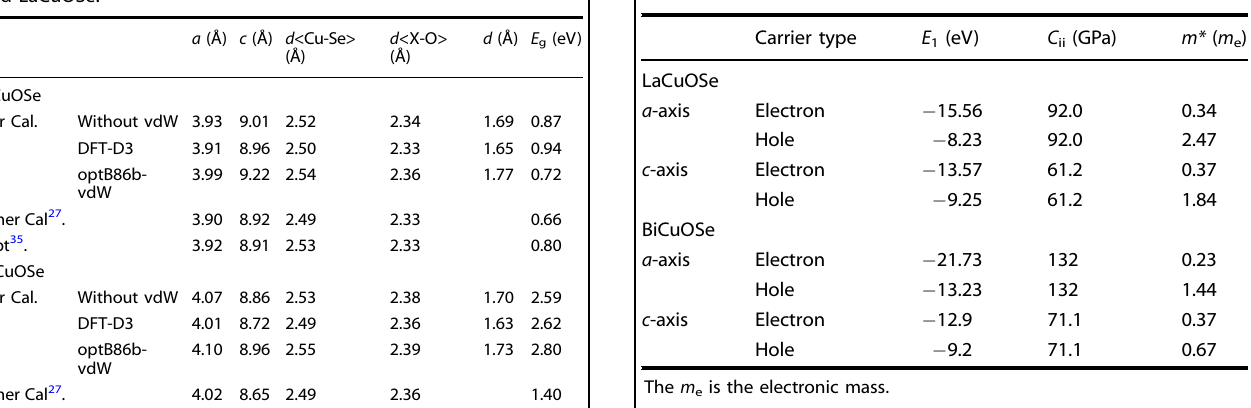
Table 1. The calculated crystal parameters and band gaps of BiCuOSe and LaCuOSe. BiCuOSe Our Cal.